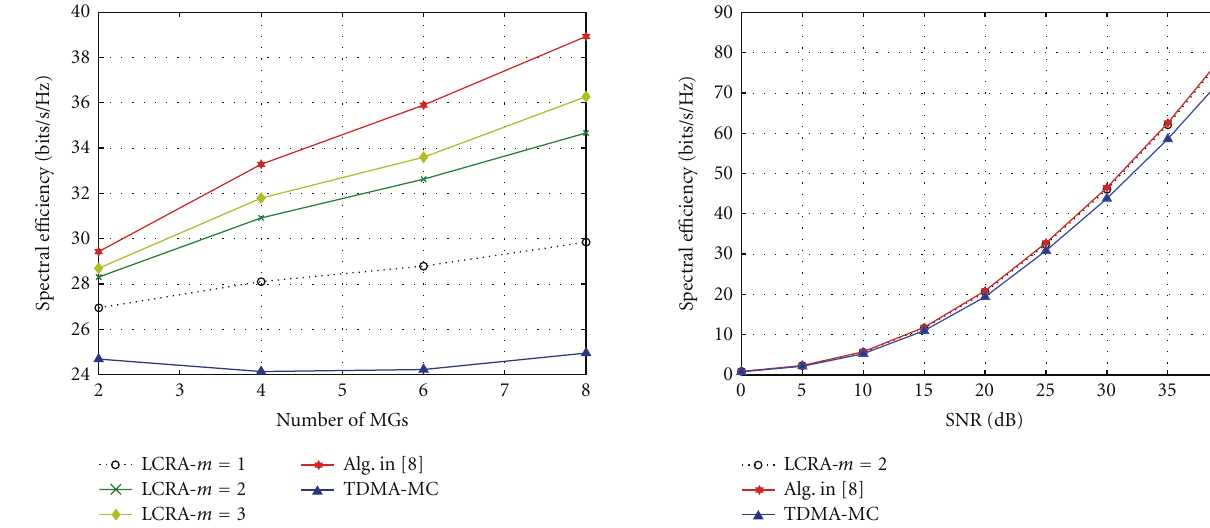
Figure 9: Spectral e ffi ciency versus SNR-no pathloss di ff erence be- tween MGs.